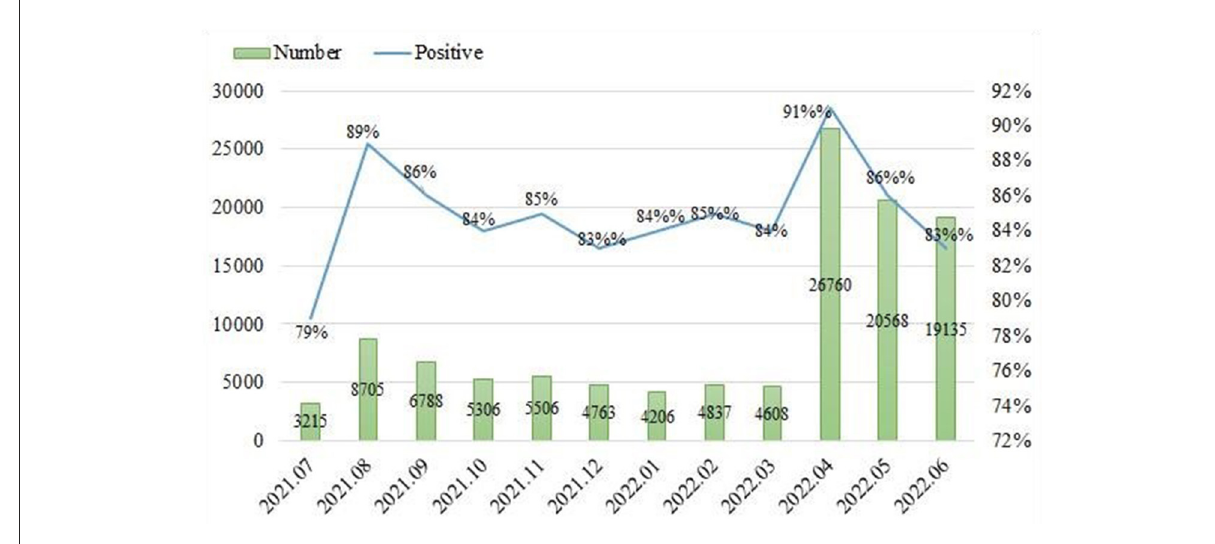
FIGURE3 Changes in the number of Weibo posts and the proportion of people’s positive